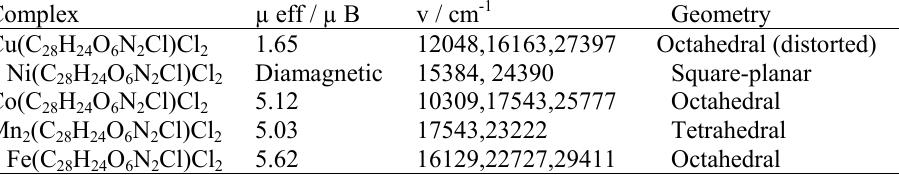
Table 3. Magnetic and electronic absorption spectral data (in DMSO) of the complexes Complex µ eff / µ B v / cm -1 Geometry